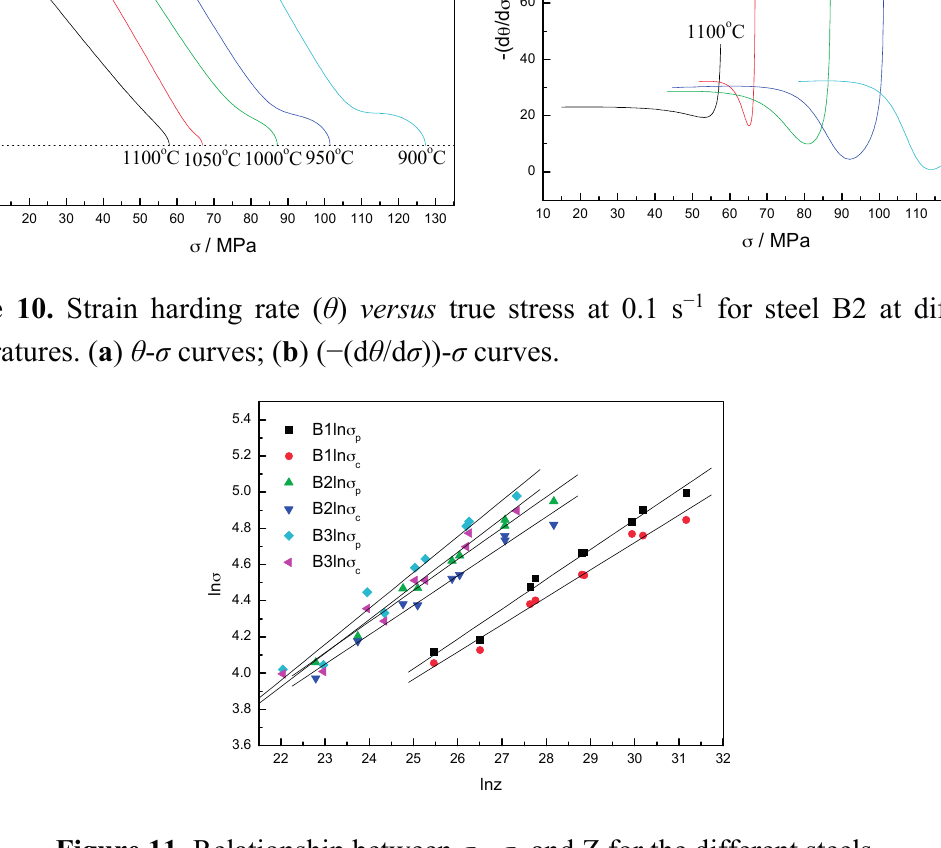
Figure 11. Relationship between σ p , σ c and Z for the different steels. Table 3. The dependence of the characteristic points under different deformation conditions on Z